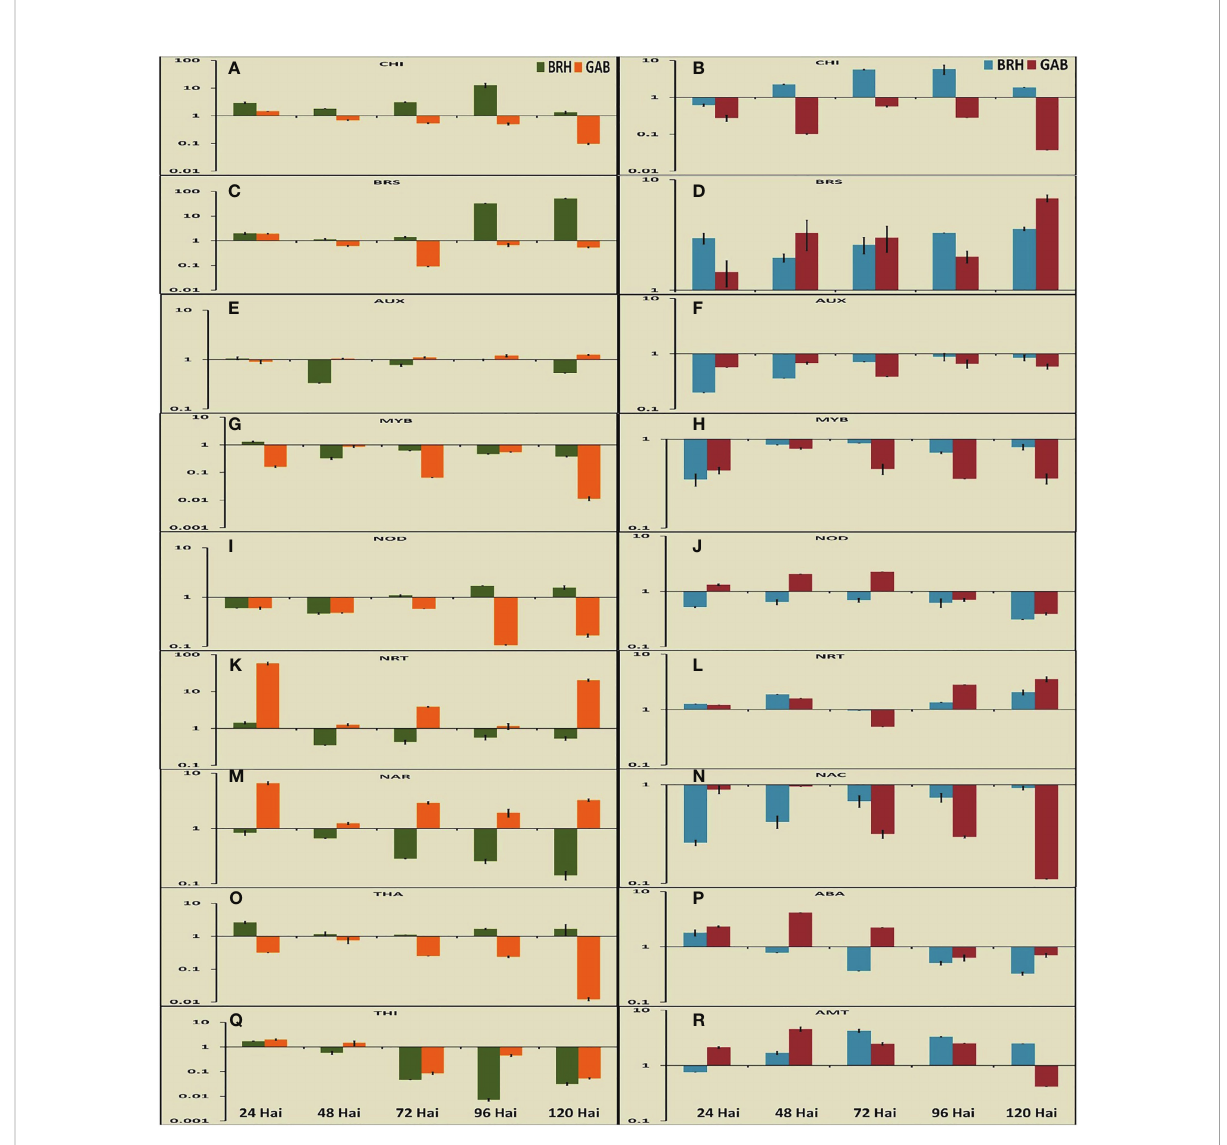
FIGURE 6 Expression pattern of important differentially expressed genes (nine in rice and nine genes in soybean) at different time points after inoculation with the diazotrophs. (A) Expression pattern of chitinase at different time points in rice. (B) Expression pattern of chitinase at different time points in soybean. (C) Expression pattern of brassinosteroid insensitive 1-associated receptor kinase at different time points in rice. (D) Expression pattern of brassinosteroid receptor at different time points in soybean. (E) Expression pattern of auxin response factor at different time points in rice. (F) Expression pattern of auxin-inducible protein at different time points in soybean. (G) Expression pattern of MYB transcription factor at different time points in rice. (H) Expression pattern of MYB transcription factor at different time points in soybean. (I) Expression pattern of Medicago truncatula nodulins at different time points in rice. (J) Expression pattern of Early Nodulins36A protein at different time points in soybean. (K) Expression pattern of high-af fi nity nitrate transporter (NRT) at different time points in rice. (L) Expression pattern of high-af fi nity NRT at different time points in soybean. (M) Expression pattern of nitrate transport accessory protein (NAR) at different time points in rice. (N) Expression pattern of NAC transcription factor at different time points in soybean. (O) Expression pattern of thaumatin at different time points in rice. (P) Expression pattern of abscisic acid at different time points in soybean. (Q) Expression pattern of thionin at different time points in rice. (R) Expression pattern of ammonium transporter at different time points in